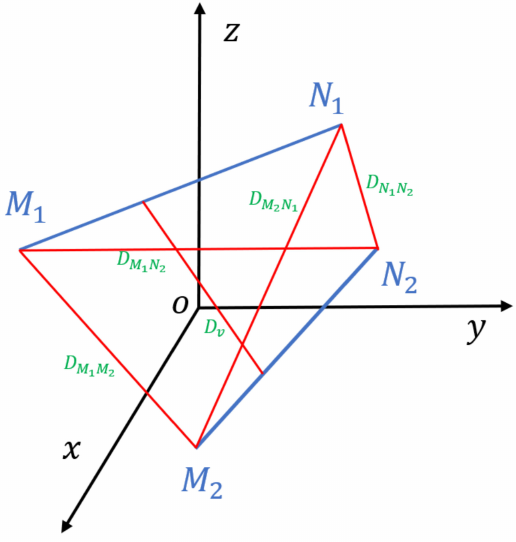
Figure 4. Determination of the distance between